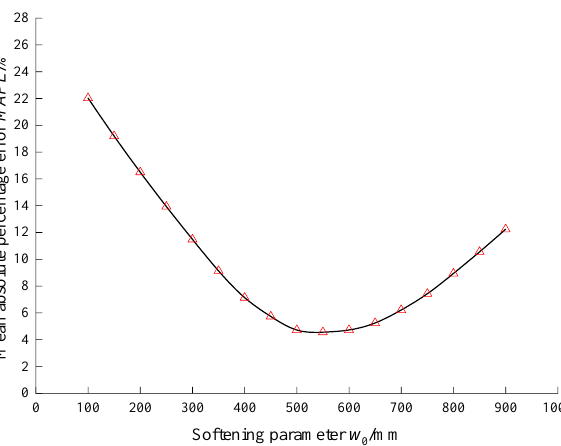
Figure 8. Determination of the softening parameter ( w 0 ). Based on the optimal w 0 and F Pre obtained above, the critical crack length of speci- Hmax mens of different sizes with an initial α c of 0.4 was calculated using Equations (3) and (10). Figure 9 shows that each data point is located near the calculated value, with the following corresponding prediction accuracy evaluation indices: MAPE = 3.42%, RMSE = 0.02 m, a 15 = 100% and Cov = 0.02 m 2 .